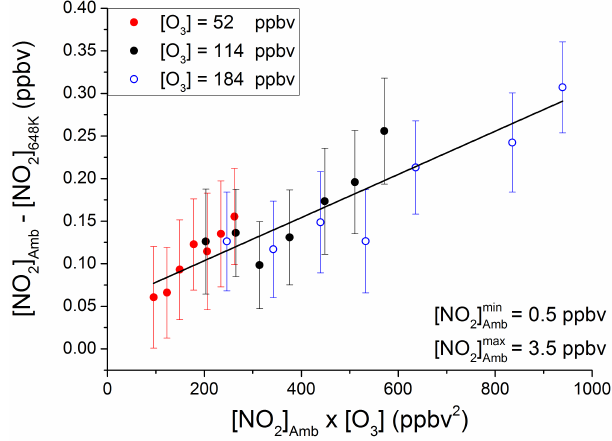
Figure 8. Influence of O 3 pyrolysis. Loss of NO 2 (in ppbv) in the heated (cid:54) ANs channel compared to the NO 2 channel vs. the product of the NO 2 and O 3 mixing